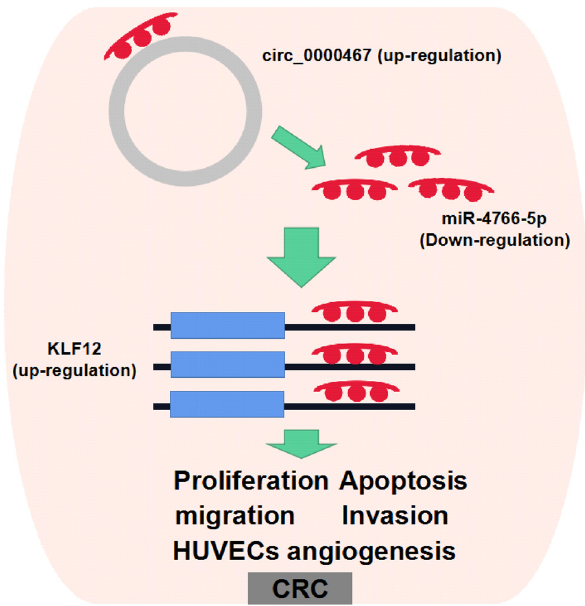
Figure 9: circ_0000467 sponged miR - 4766 - 5p to upregulate KLF12 expression to regulate the cellular behaviors of CRC